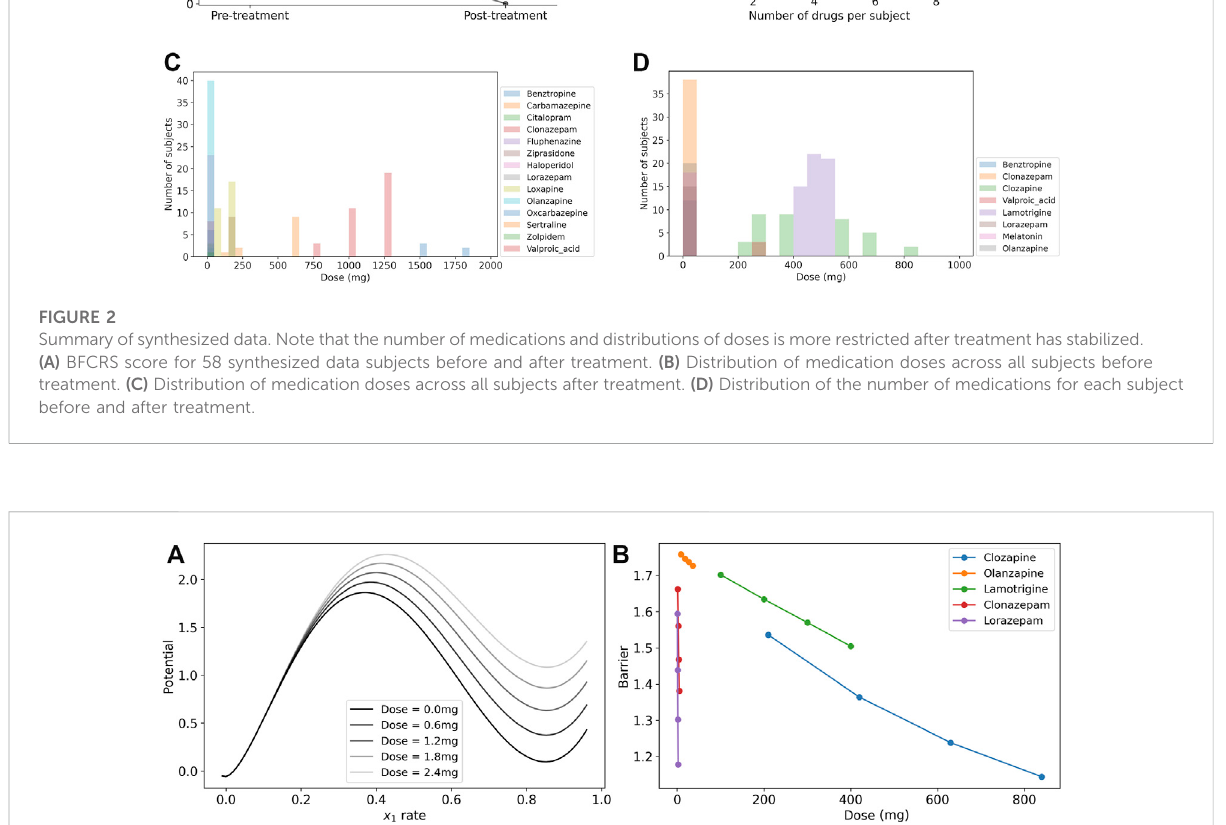
FIGURE 3 Dose response of the model barrier to medications. (A) Dose response of potential function (line integral of _ x 1 in Eq. 1 on the x 0 -nullcline) to show how the barrier becomes smaller with increasing doses of lorazepam. The two stable fi xed points are where the excitatory rate is 0 and ~0.85. Thepeakofthebarrieristheunstable fi xedpointwheretheexcitatoryrateis~0.4.Theverticaldistancefromthehigh-ratebasintotheunstablepeak is thebarrier. (B) Dose response of model parameters for clozapine, olanzapine, lamotrigine, clonazepam, and lorazepam. The barrier between the high-rate state and the low-rate state for these medications is reduced in the